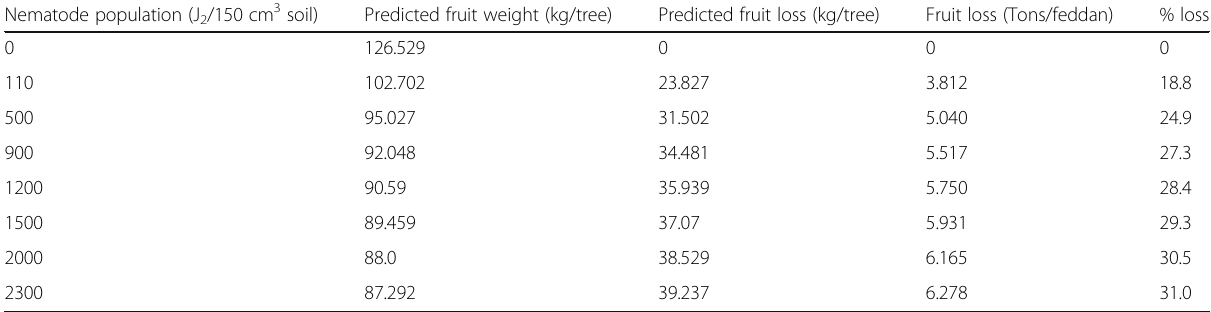
Table 2 Predicted marketable fruit losses in “ banzaheer ” lemon ( Citrus aurantifolia ) at increasing citrus nematode density (Abd- Elgawad et al. 2016) Nematode population (J 2 /150 cm 3